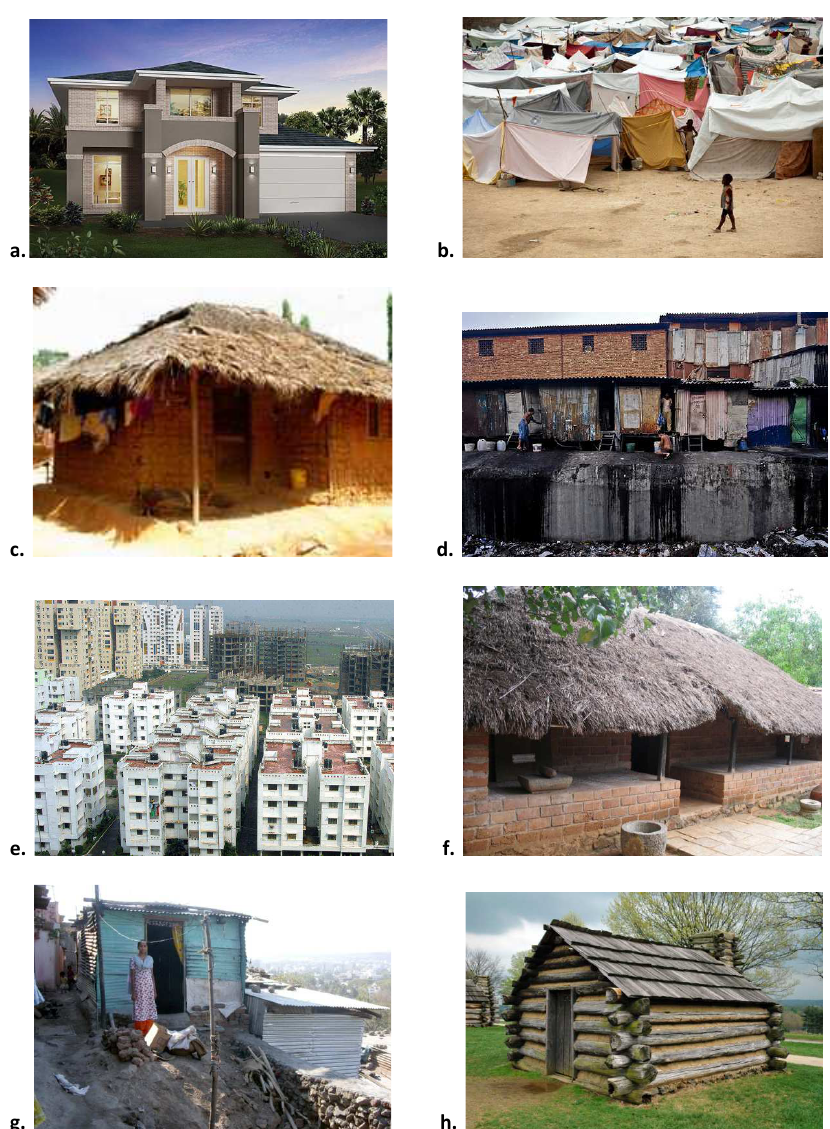
Figure 2. Types of housing. a. American house b. Temporary cloth shelters c. Mud brick shanty d. Urban slums in India e. Urban apartment complex in India f. Brick and wood house with a concrete floor g. Tin shanty h. Wooden log